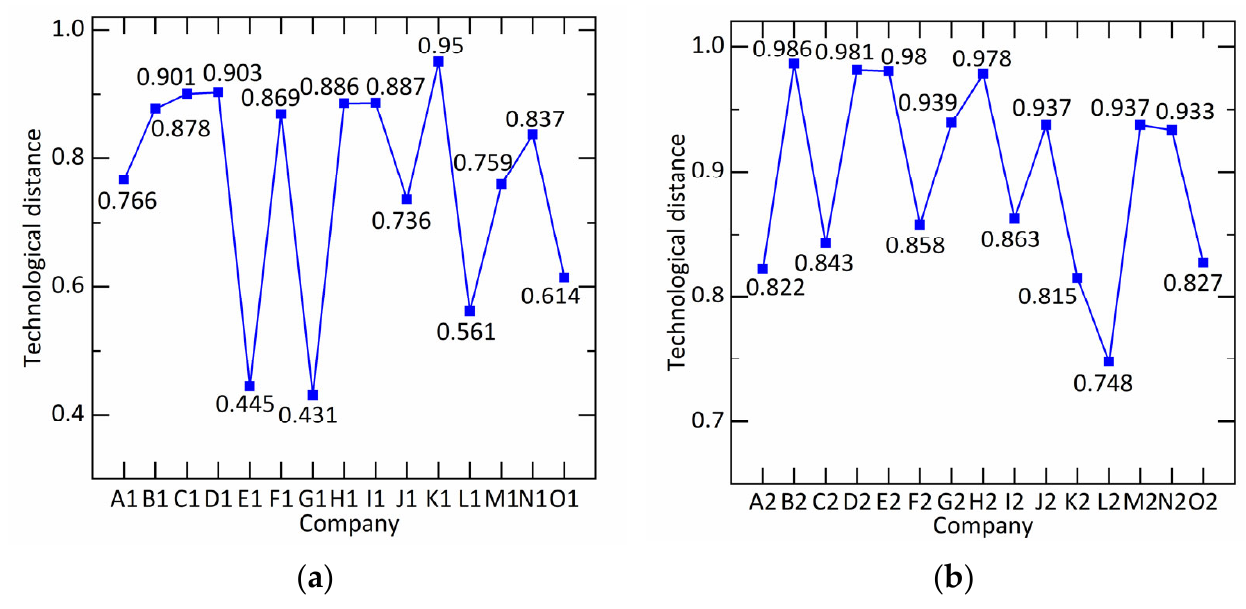
Figure 13. Technological distance of companies: ( a ) Rotation; ( b ) vacuum absorption.